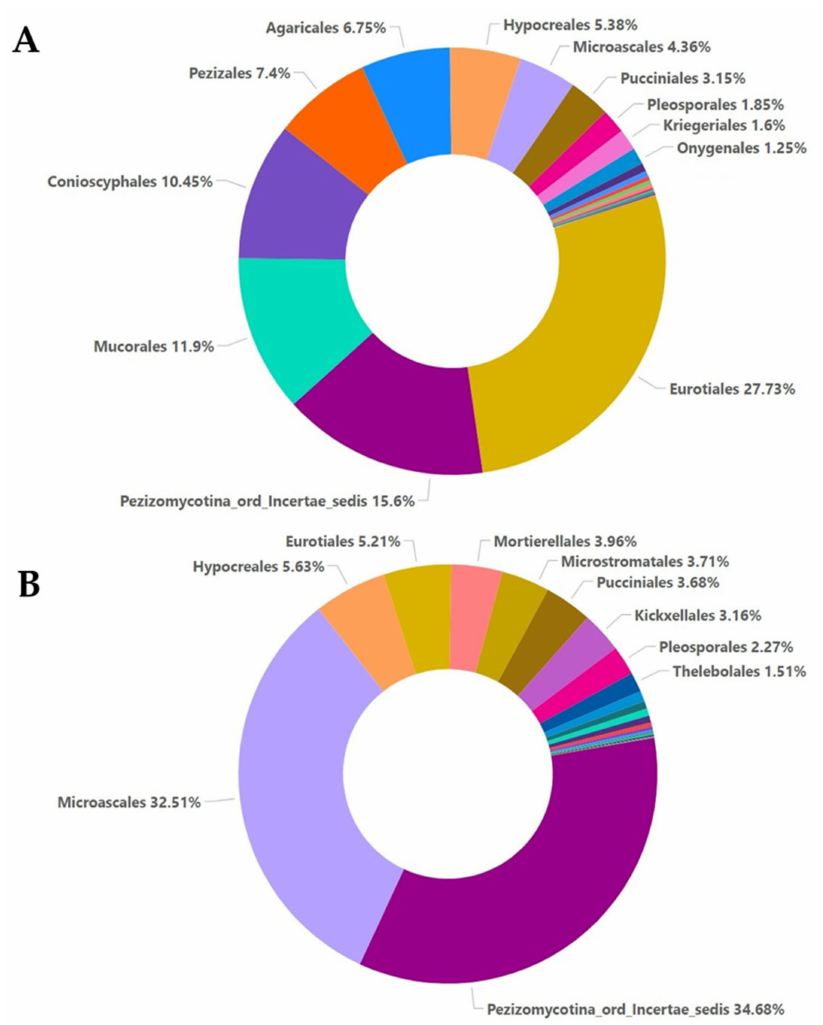
Figure 3. Relative abundance with percentages above 1% for the order taxa, as shown for the non-inoculated samples ( A ) and inoculated samples ( B